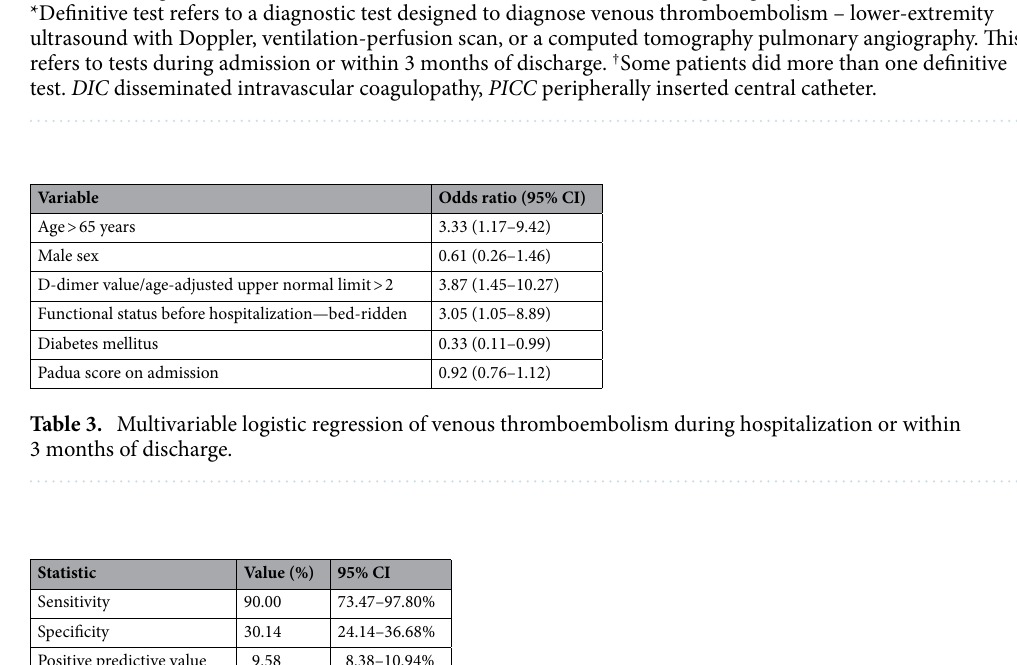
Table 2. Baseline characteristics comparing patients with a positive age-adjusted D-dimer test and imaging evaluations. Significant values are in bold. *Positive test is defined according to age-adjusted D-dimer.